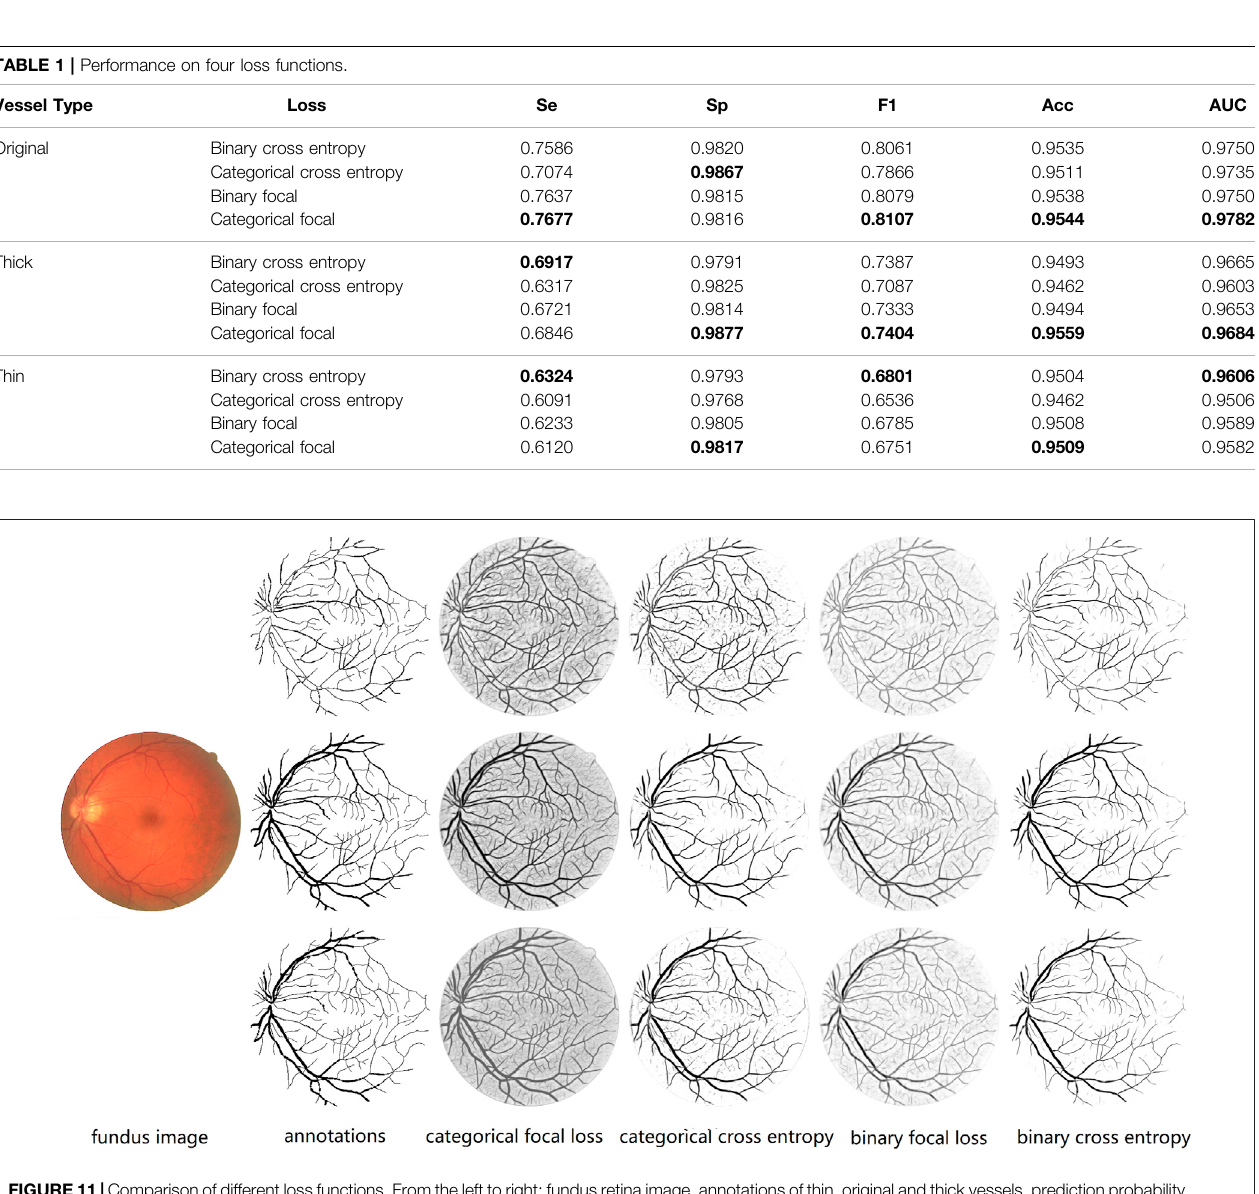
FIGURE 10 | Performance obtainedbycategorical focal lossonDRIVE according todifferent γ . When γ is2.0,the best valuesofAUC, Acc,and Sp can beobtained.